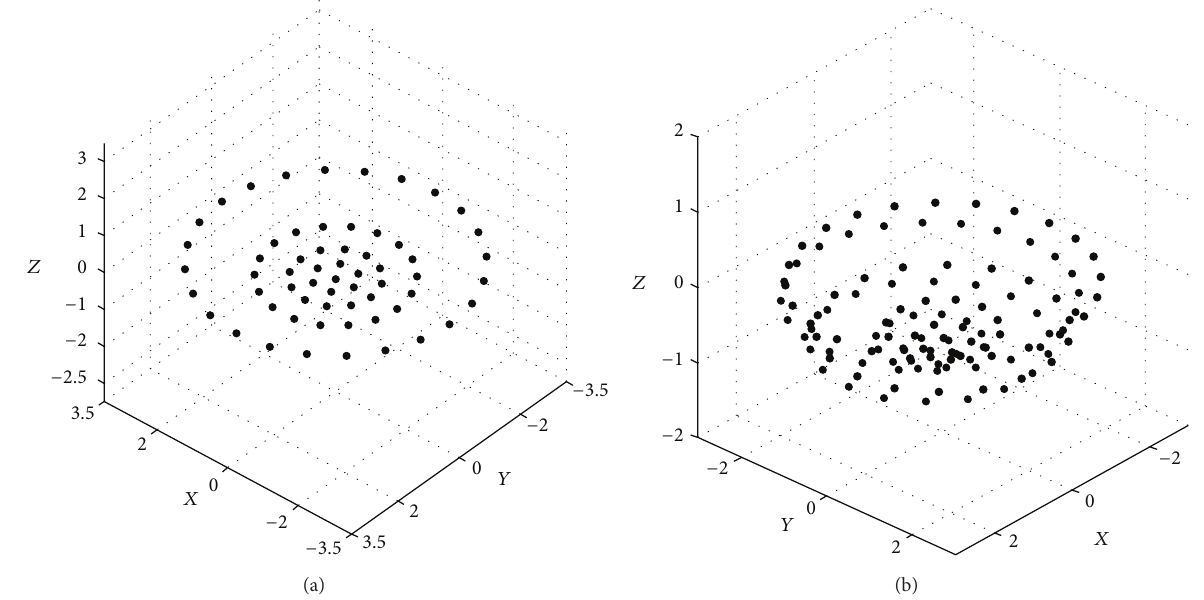
Figure 6: Element distribution of VRA for GEO satellites: (a) uniform excitation and (b) concentric excitation.